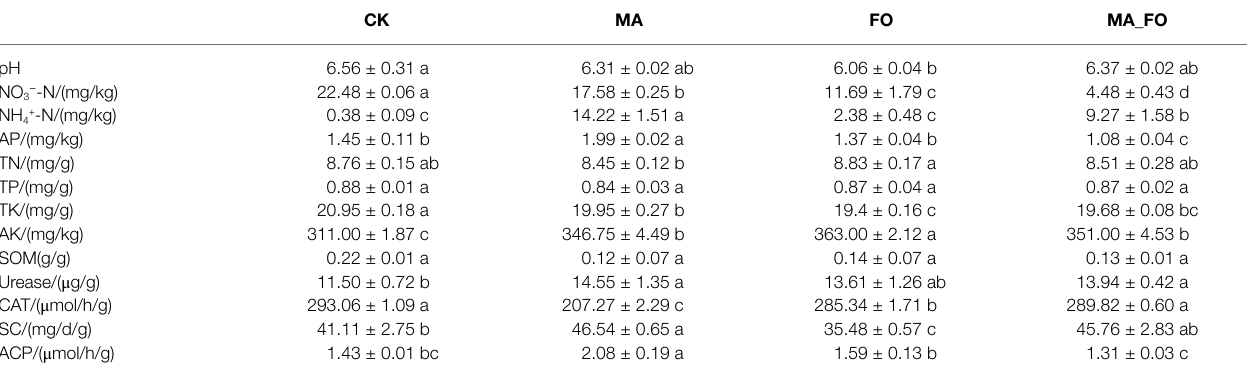
TABLE 2 | Physicochemical and enzyme activity characteristics of ginseng rhizosphere soil under different inoculation treatments.